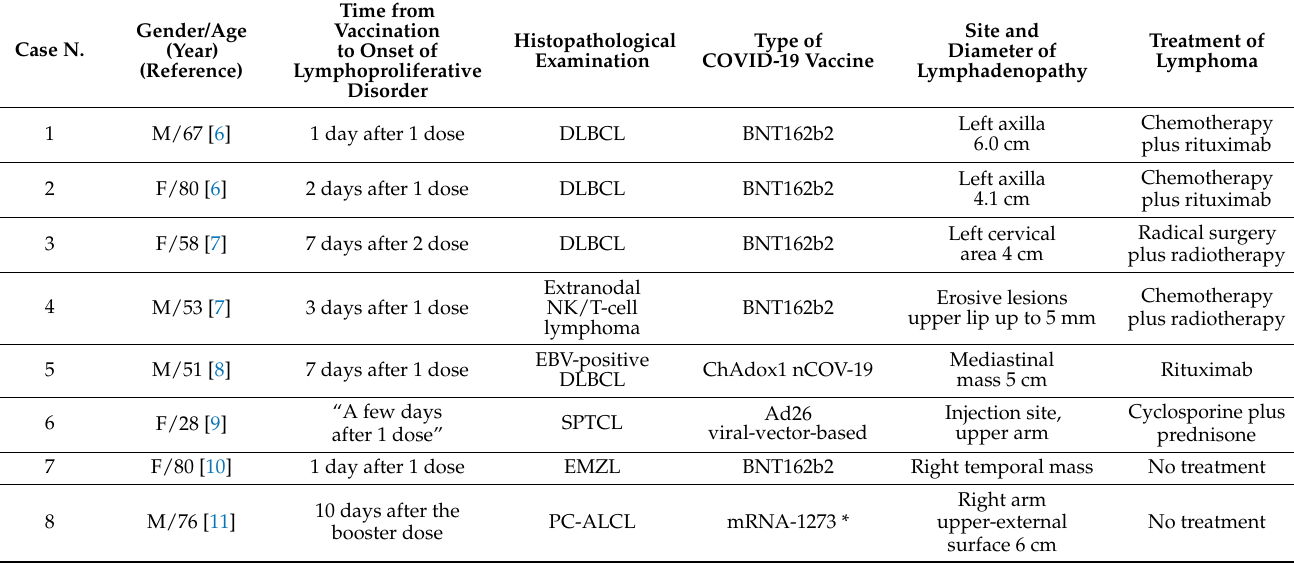
Table 1. Review of the literature: malignant lymphoma diagnosed in the context of the mRNA COVID-19 vaccination (Ad26: adenovirus type 26, ALCL: anaplastic large-cell lymphoma, DLBCL: diffuse large-B-cell lymphoma, EBV: Epstein–Barr virus, EMZL: extranodal marginal zone lymphoma, PC-ALCL: primary cutaneous anaplastic large-cell lymphoma, SPTCL: subcutaneous panniculitis-like T-cell lymphoma). * The two previous vaccination doses were